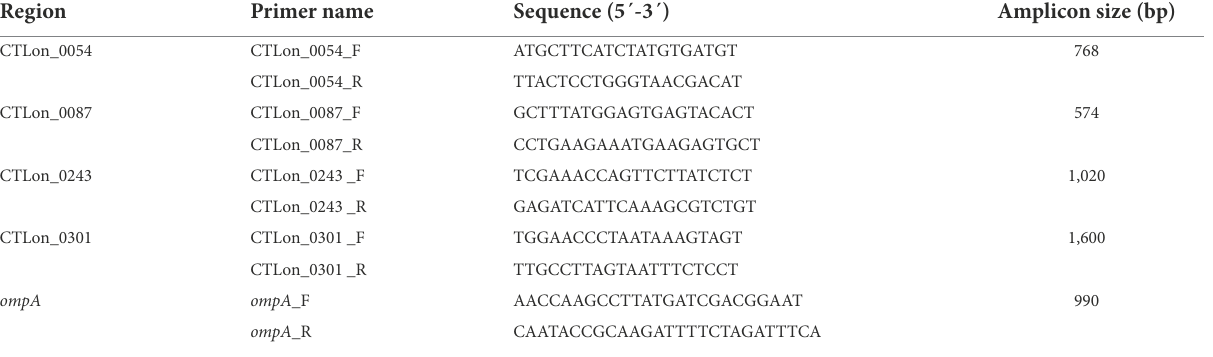
TABLE 1 Primers used for amplification and sequencing of the selected genes and ompA gene .